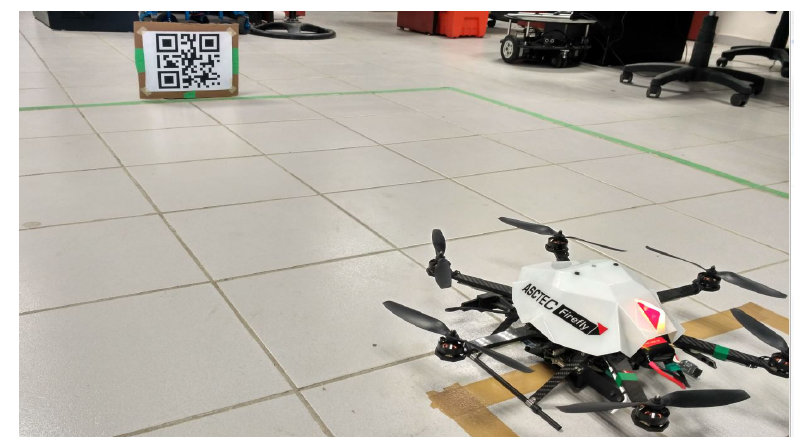
Figure 10. Actual experiment configuration. The corners of the Quick Response (QR) code represent the 3D